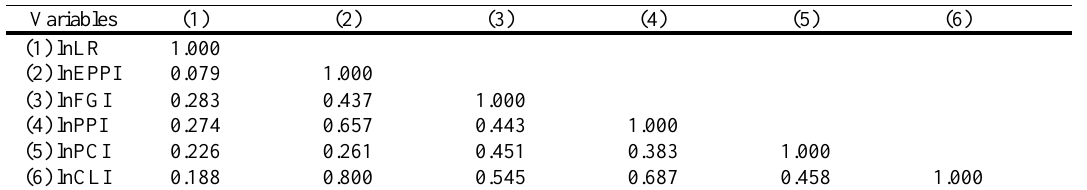
Table 1: Pairwise correlations matrix